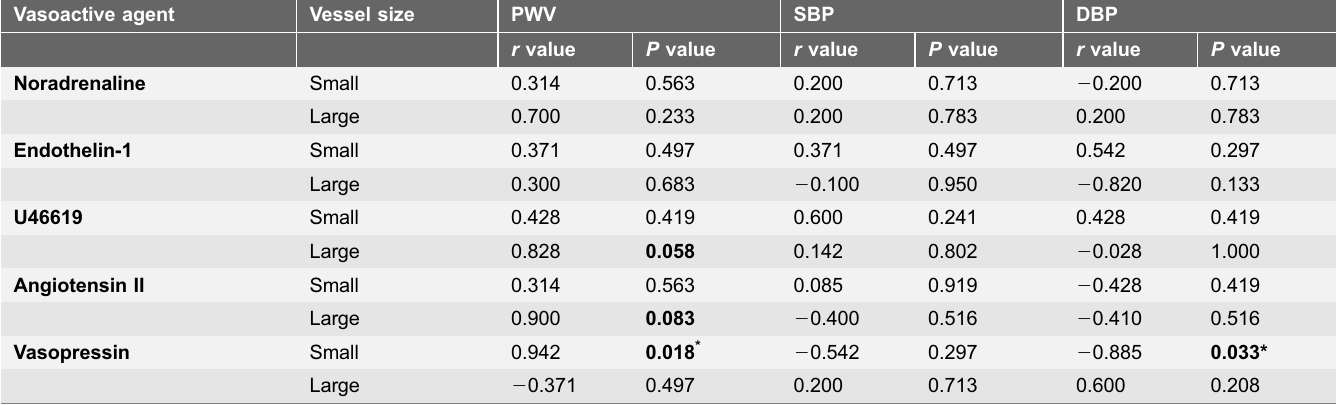
Table 3. Correlations of in vivo data with ex vivo normalised vasoconstrictor responses of arteries obtained from HD patients. Vasoactive